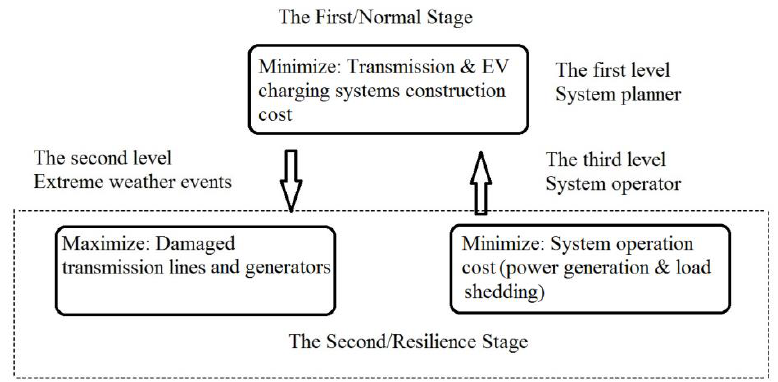
Figure 1. The two-stage / tri-level model developed for power system resilience enhancement.